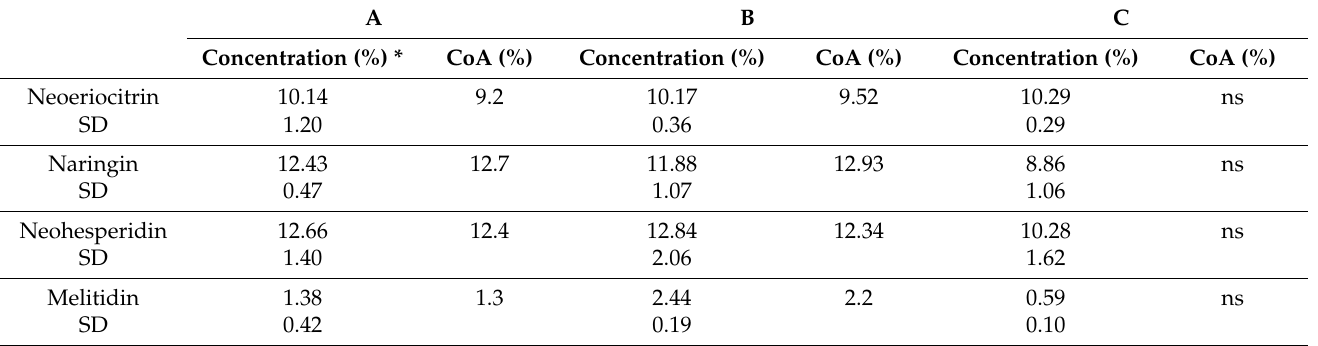
Table 1. Concentrations of flavonoid glycosides in bergamot